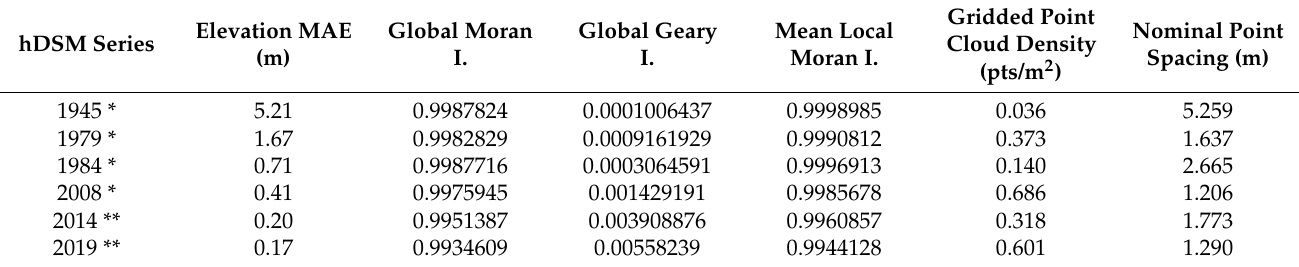
Table 4. Summary of the quality assessment of hDSM series. * Depict ALS-Validation Points